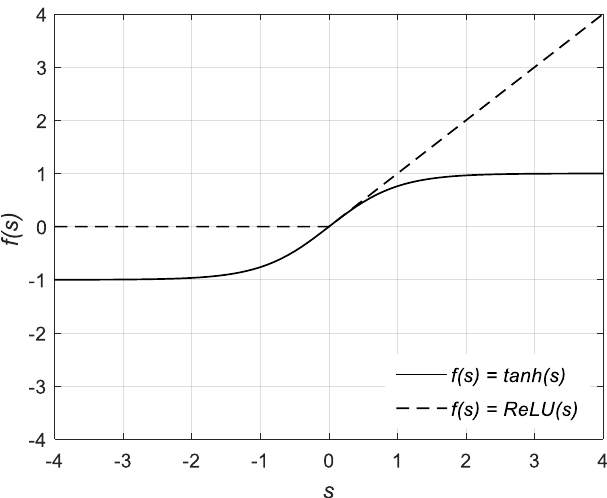
Figure 3. The hyperbolic tangent and the rectified linear unit ( ReLU ) functions.